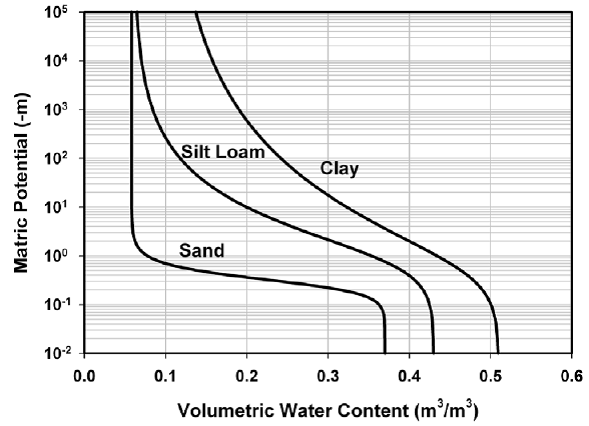
Figure 1. Water retention curve that links the two variables i or } depending on the type of soil [Tuller and Or 2005].